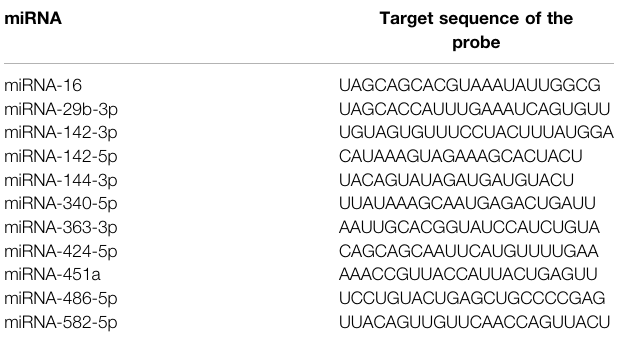
TABLE 3 | The sequences of the validated miRNAs in real-time